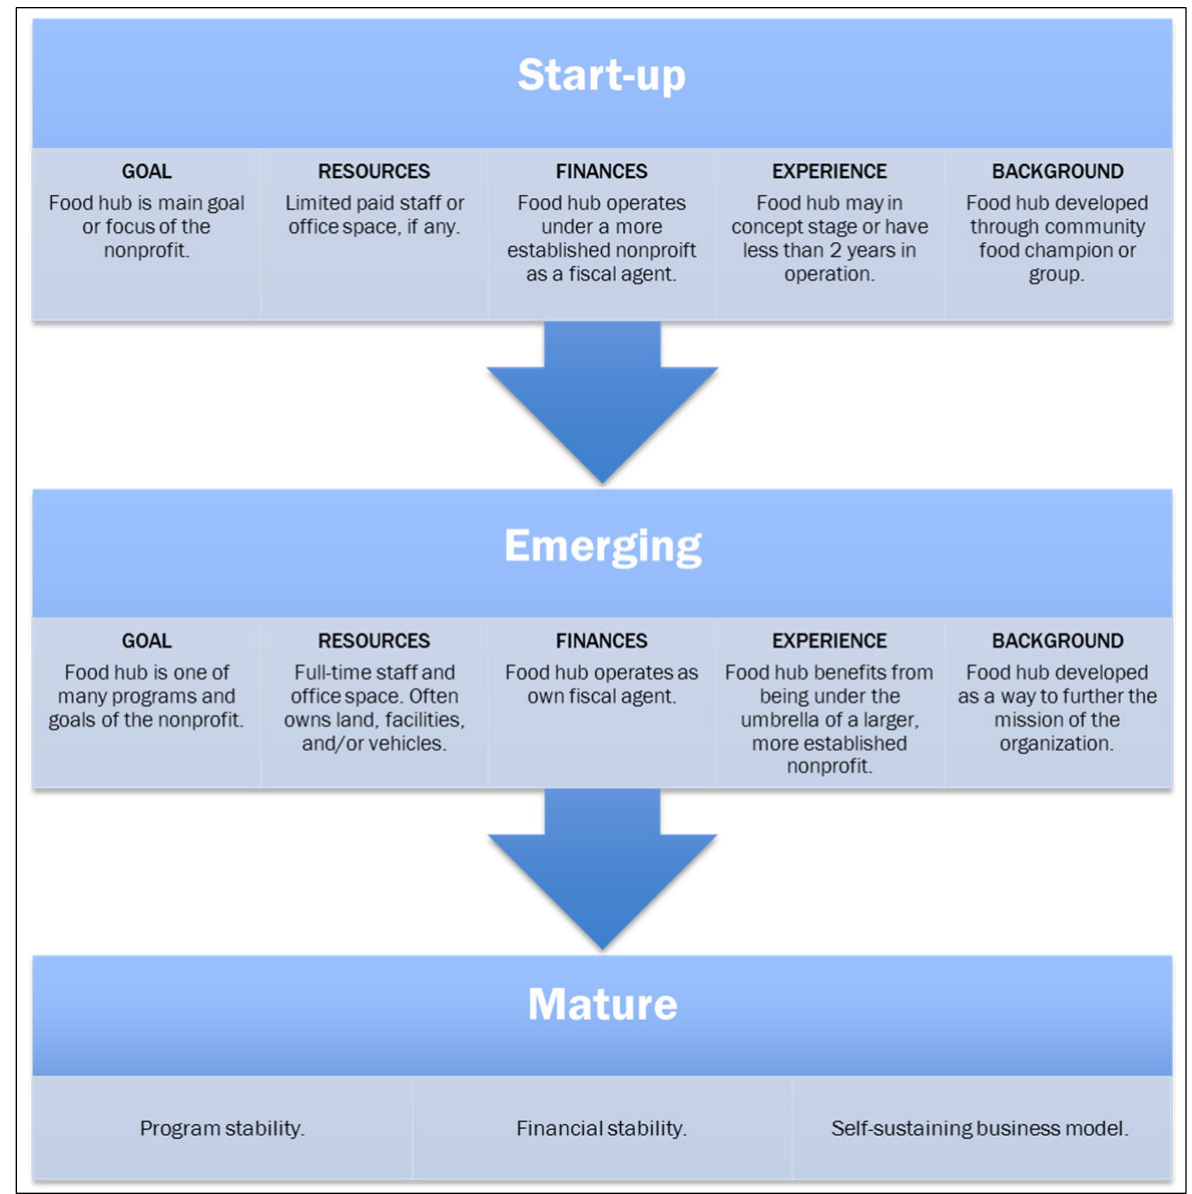
Figure 1. Food Hub Development Stages and Their